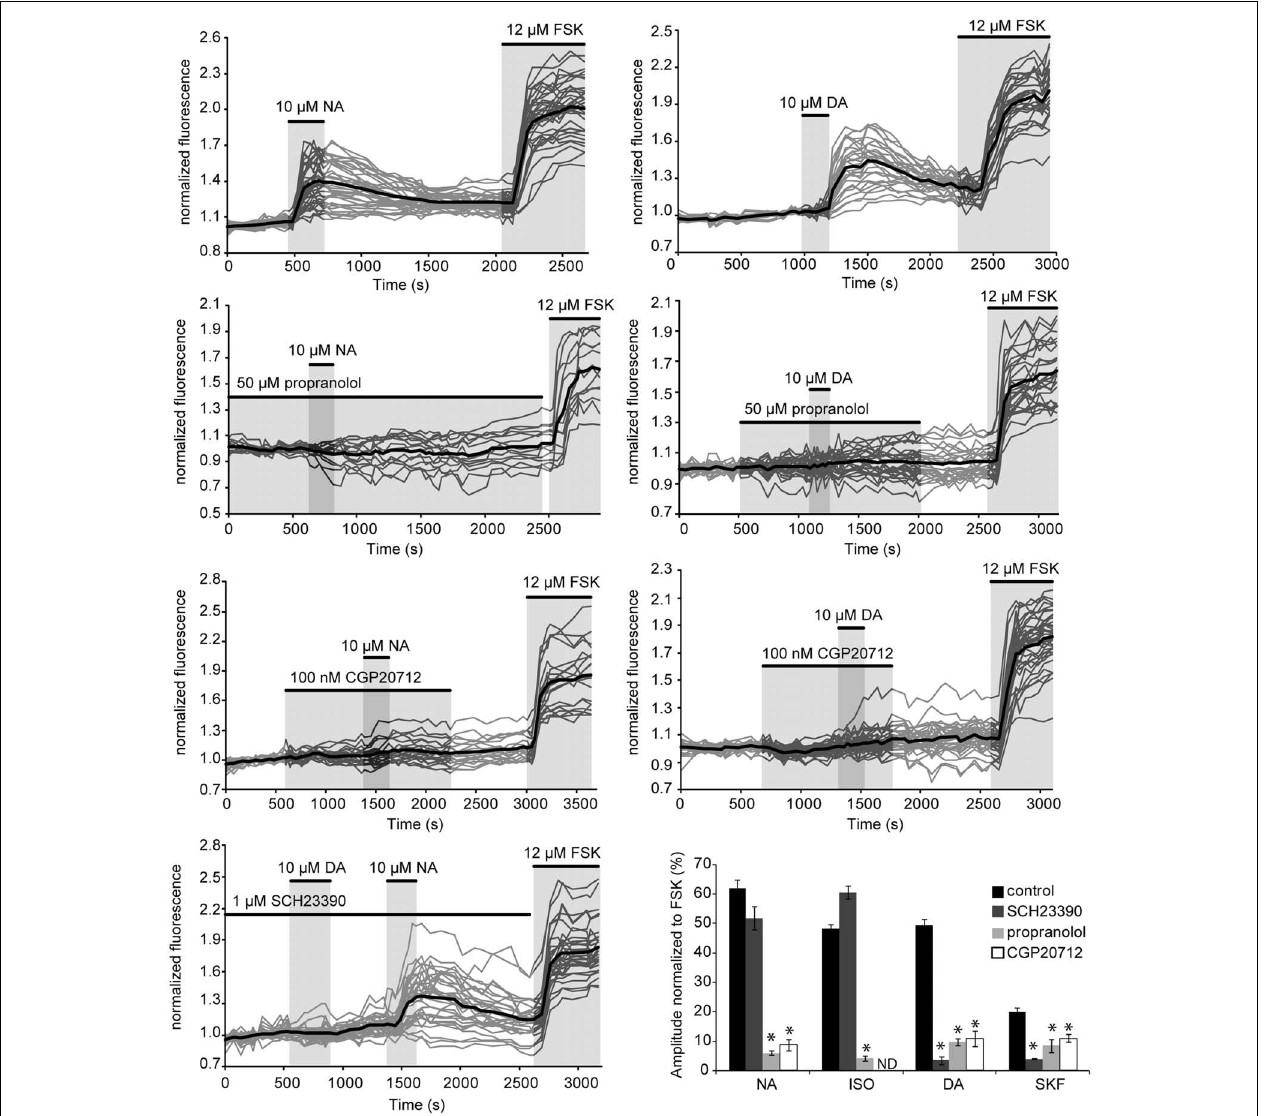
FIGURE 5 | NA and DA receptors involved in PKA activation. Graphs show the effects of antagonists propranolol (beta adrenergic), CGP20712 (beta1-specific) and SCH23390 (D1/D5) on responses to NA and DA of layer II/III pyramidal neurons of the parietal cortex. Gray traces correspond to the fluorescence intensity normalized to the baseline value measured on individual neurons expressing the PKA sensor in parietal cortical slices (averaged traces are in black). Histograms summarize the effects of these antagonists on responses to NA, DA, the beta adrenergic agonist